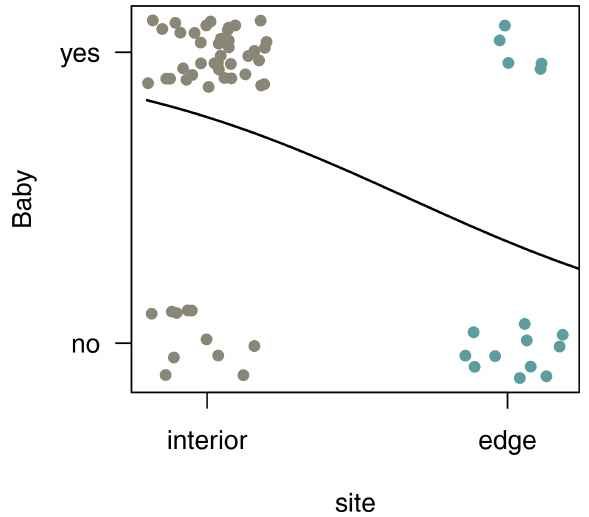
Figure 7. Probability (yes or no) of giving birth for females living in the edge or forest interior